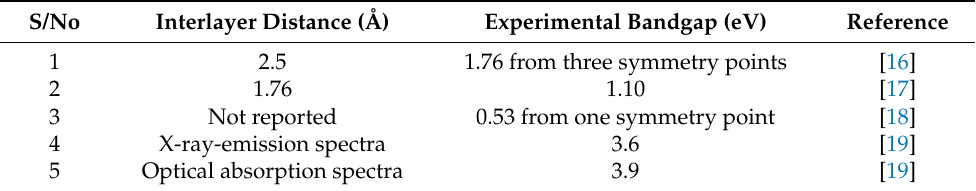
Table 2. Reported band gaps of h -BN from the literature.